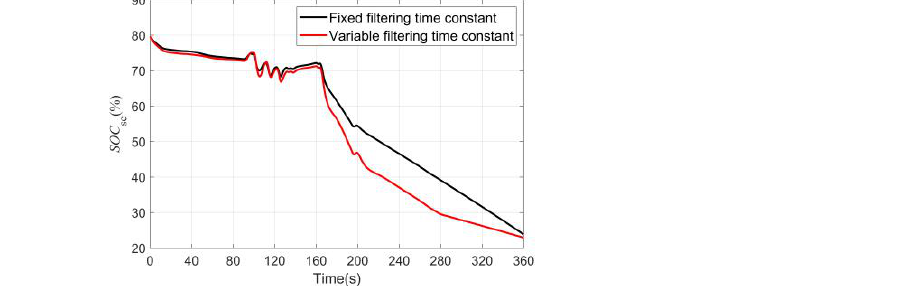
Figure 21. Comparison of the supercapacitor’s SOC value change under constant and variable filter time constants.